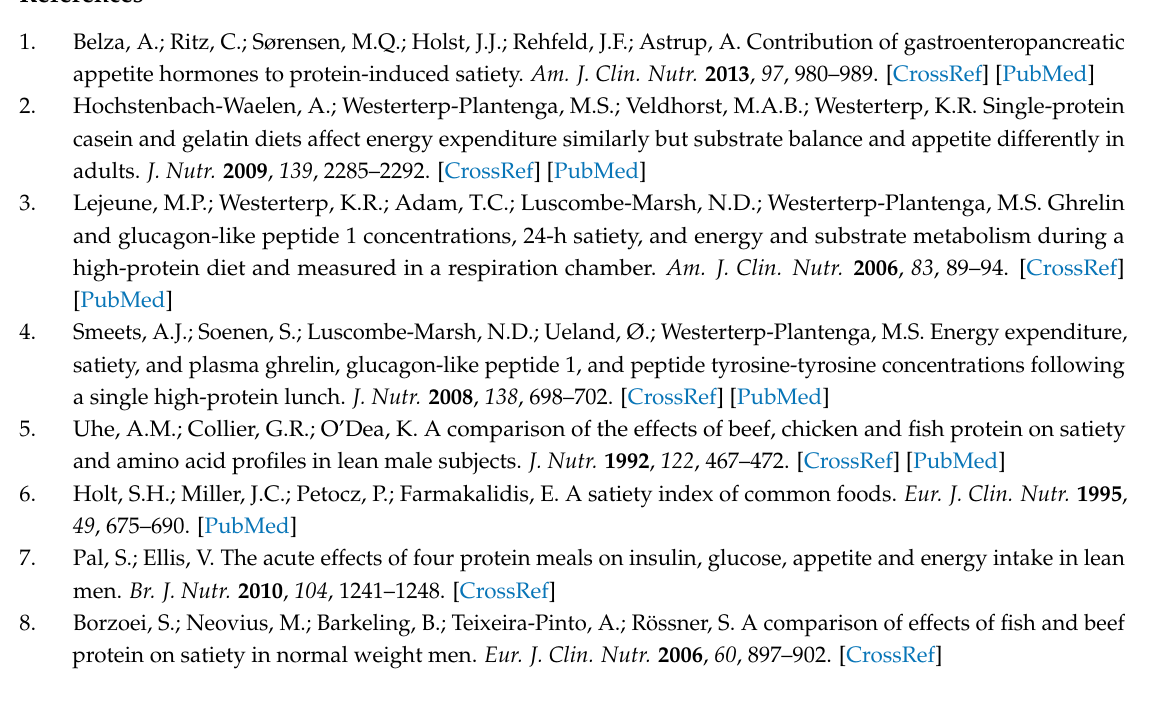
Figure S1: Mean unadjusted 200 min changes in serum C-peptide and plasma lactate, Table S1: Measurements in the study, Table S2: Differences between the four test meals in plasma amino acids